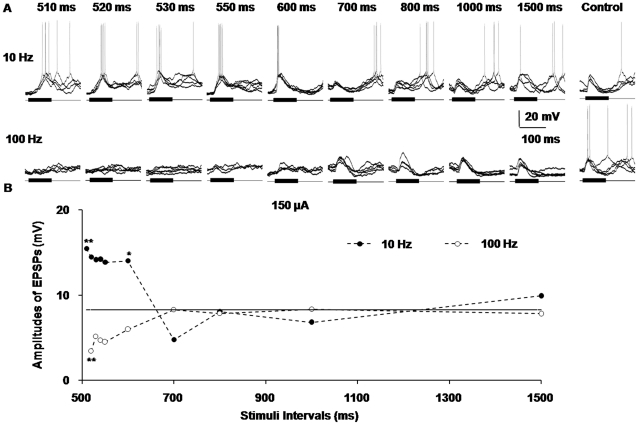
Different responses of AI neurons at varied intervals between paired stimuli.
A) Five superimposed waveforms of the paired sound-evoked responses in AI neurons after train stimulation of the MGBv at incremental intervals between the paired stimuli. B) The statistical broken line chart of the average amplitude of the EPSPs in (A). When the frequency of the train stimuli was 10 Hz, the amplitudes of the sound-evoked EPSPs significantly increased immediately after the train stimulation of the MGBv (compared with the control level), and then decreased to a level lower than the control group when the stimulus interval was extended to 700 ms. Finally, when the stimulus interval was approximately 800 ms, it reached the average amplitude of sound-evoked EPSPs without train stimulation (that is, the level of the control group). In contrast, the 100 Hz train electrical stimulation of the MGBv at first decreased the amplitudes of sound-evoked EPSPs in AI neurons to a significant low level. The amplitudes of the EPSPs then increased to the level of control group. The amplitudes of the EPSPs in both the high- and low-frequency group reached the control level and stabilized at the plateau when the stimulus interval was longer than 800 ms. (*P<0.05, **P<0.01).